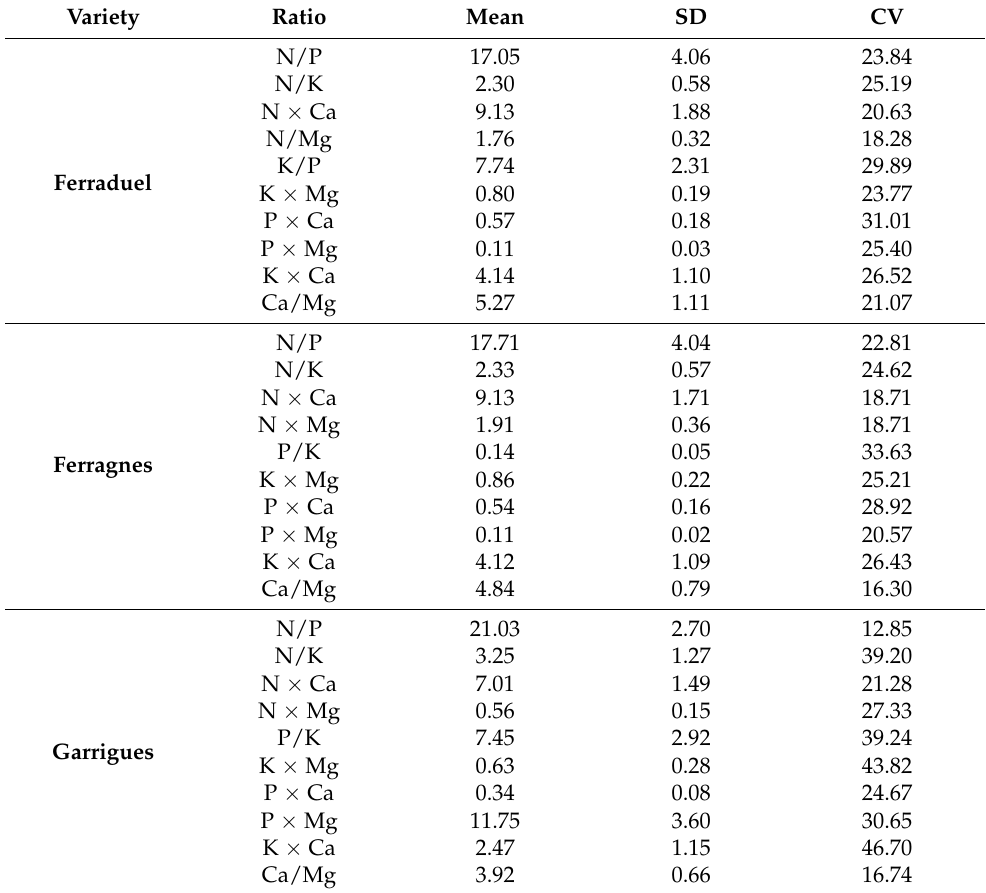
Table 4. DRIS norms established for the Ferraduel, Ferragnes, and Garrigues varieties.